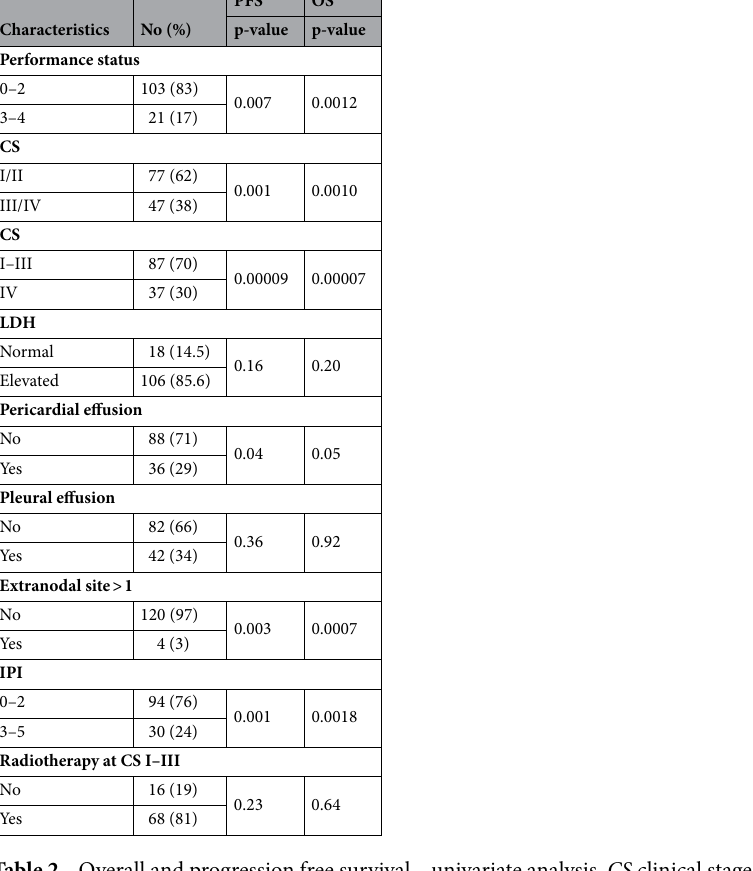
Table 2. Overall and progression free survival—univariate analysis. CS clinical stage, IPI international prognostic index, LDH dehydrogenase lactate, No number, OS overall survival, PFS progression free